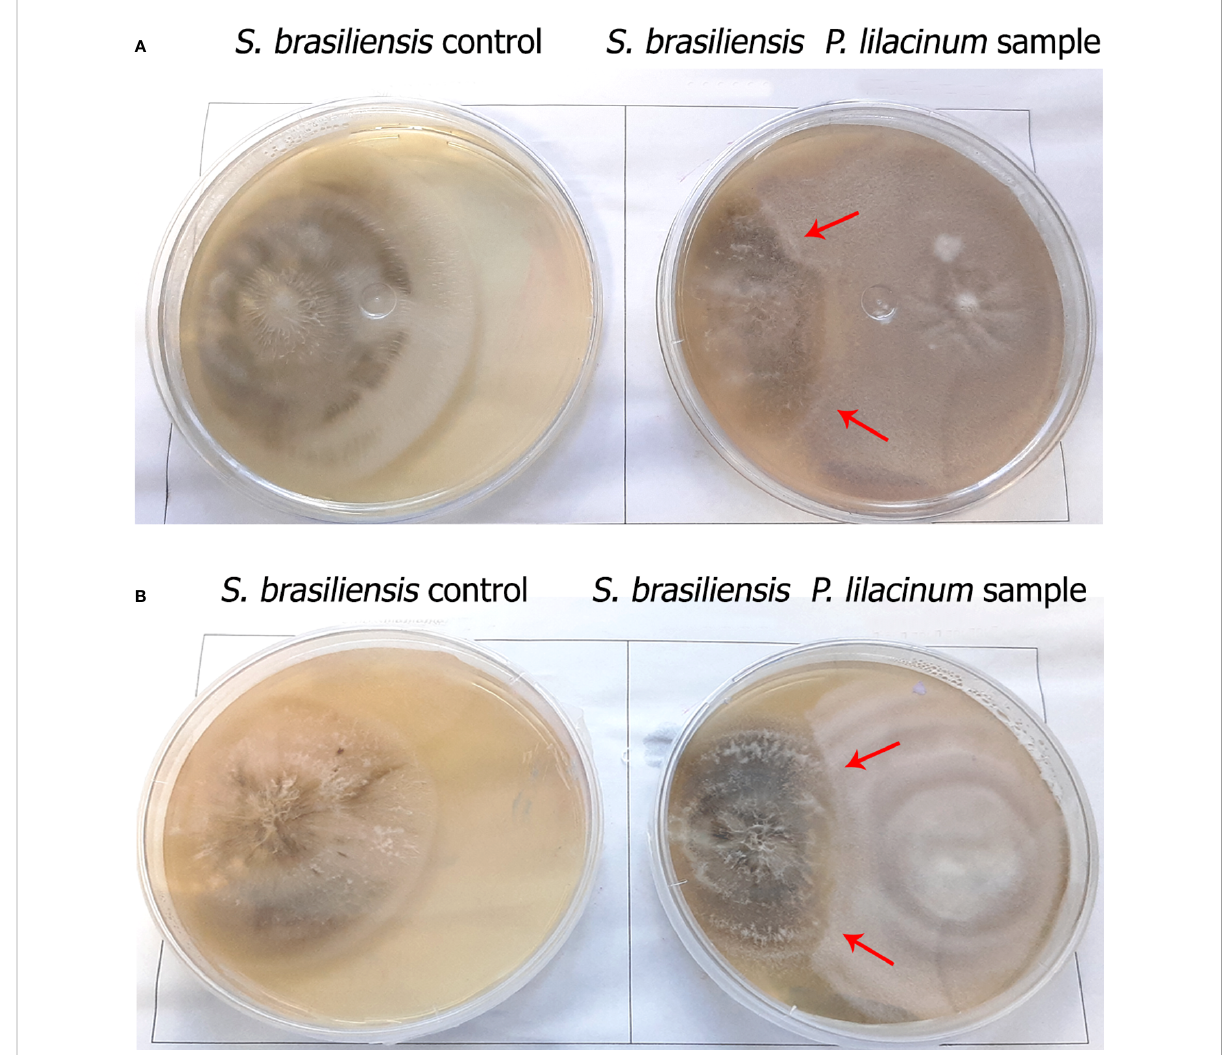
FIGURE 3 Illustration of the interaction observed between two Purpureocillium lilacinum isolates ( A LTBBF-PL4; B LTBBF-PL9) and Sporothrix brasiliensis on the 28 th day of incubation. Control plates on the left show the growth of S. brasiliensis isolates and on the right plates show the interaction type “ overgrowth by antagonist ” which S. brasiliensis ceased its growth and was overgrown by P. lilacinum